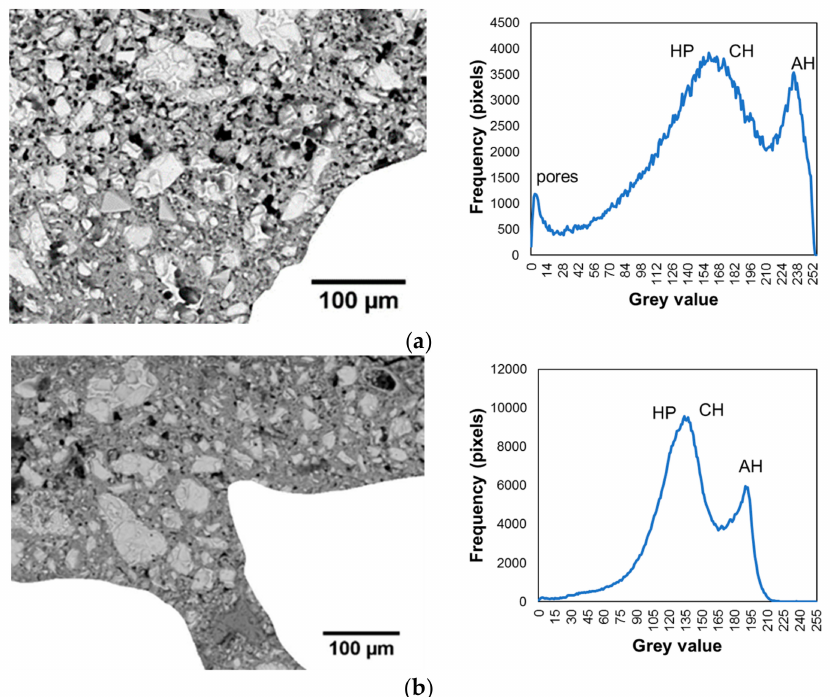
Figure 13. Exemplary backscattered electron (BSE) images of the samples taken from the subsurface zone of the cement mortar used to make the overlay with the concrete substrate, which were made using scanning electron microscope (SEM); and gray scale histograms for the mortar: ( a ) without Al 2 O 3